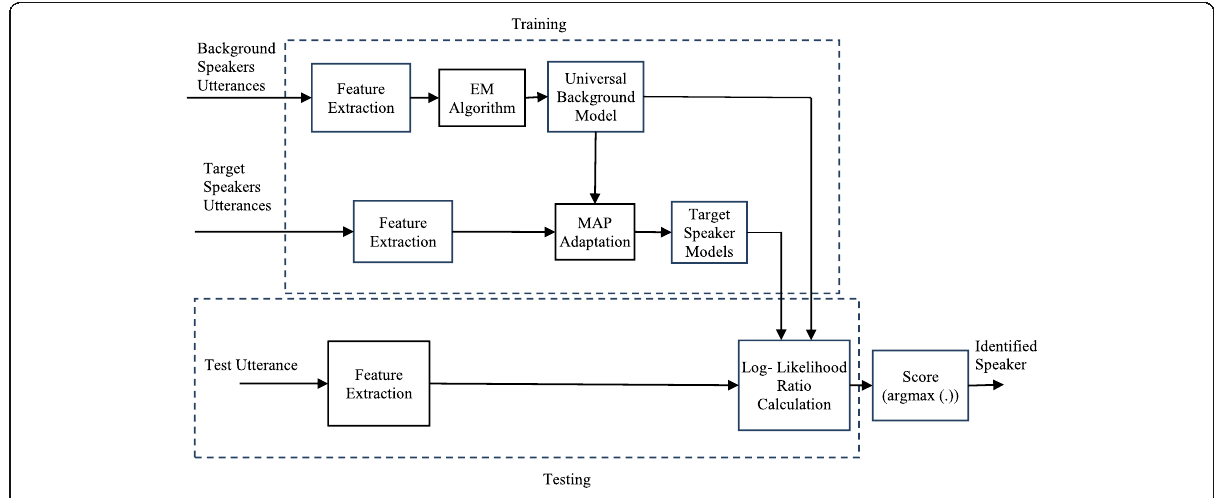
Fig. 1 The block diagram of a typical speaker identification system